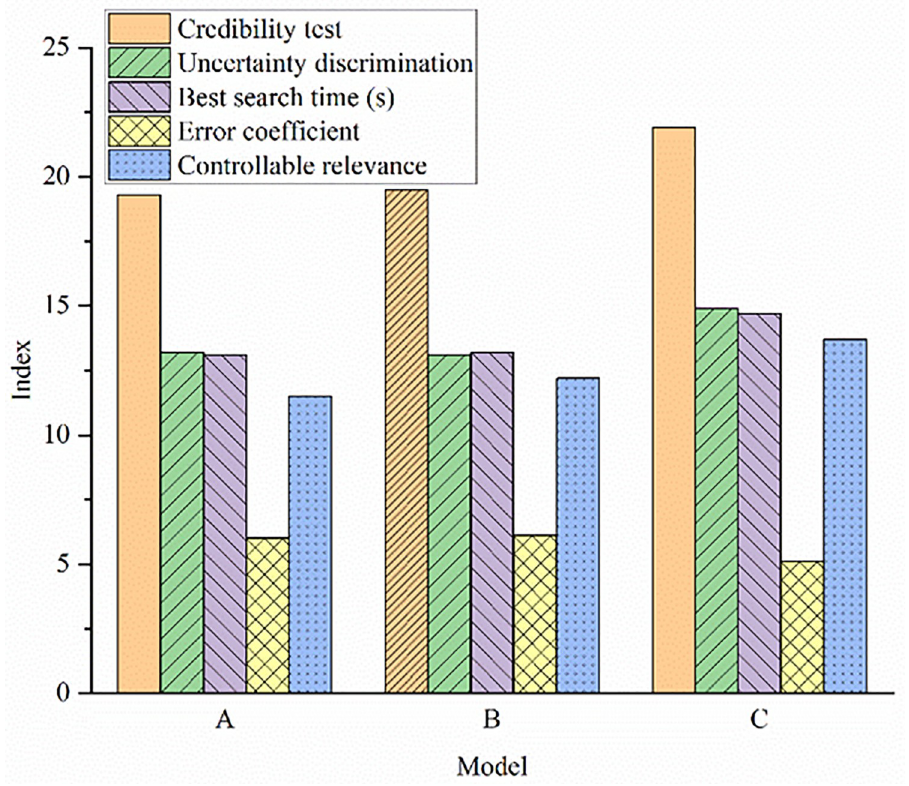
Fig 9. Performance comparison of various models (A: C&M-CVPDSS model; B: Prediction model of the actual effect of goods identification; C: DPMES).